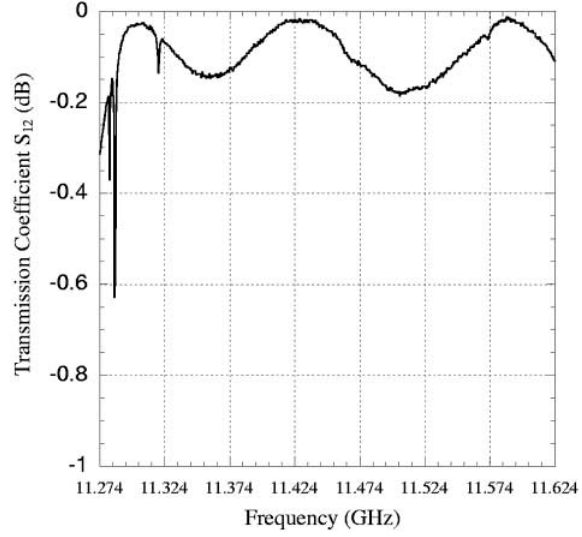
FIG. 14. Measured transmission coefficient for two wrap- around mode converters back-to-back. The device is optimized at 11.424